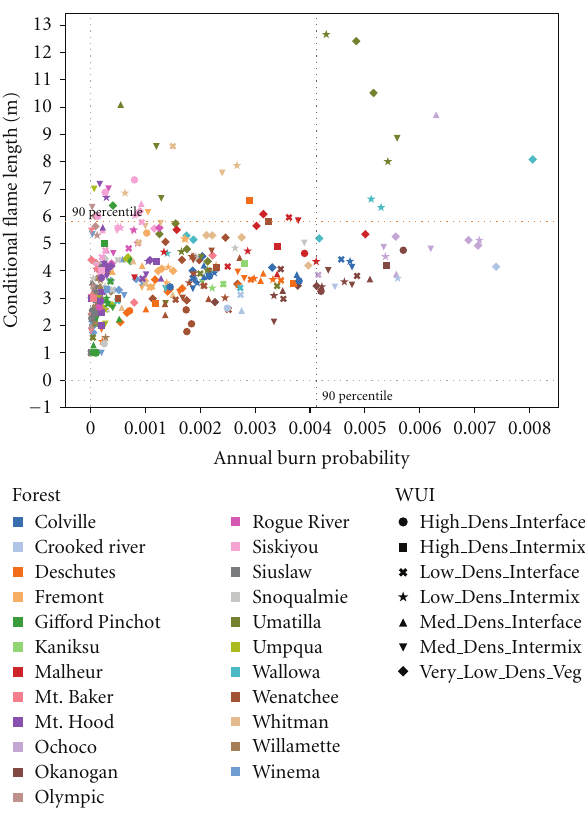
Figure 9: Scatter plot of annual burn probability versus conditional flame length estimated with for wildland urban interface (WUI) adjacent to national forests in Oregon and Washington State, US WUI definitions were obtained from the SILVIS project [103]. Fire simulation outputs obtained from [104]. Each point represents the average value for the WUI polygon. The figure shows relative risk in terms of likelihood (annual burn probability) and potential intensity (average flame length) for the individual